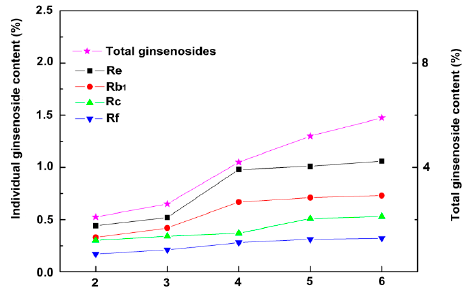
Figure 3. The changes of total and individual ginsenoside contents at different ages of fresh ginseng growth. The left Y -axis represents individual ginsenoside contents, while the right side of the Y -axis represents total ginsenoside content.